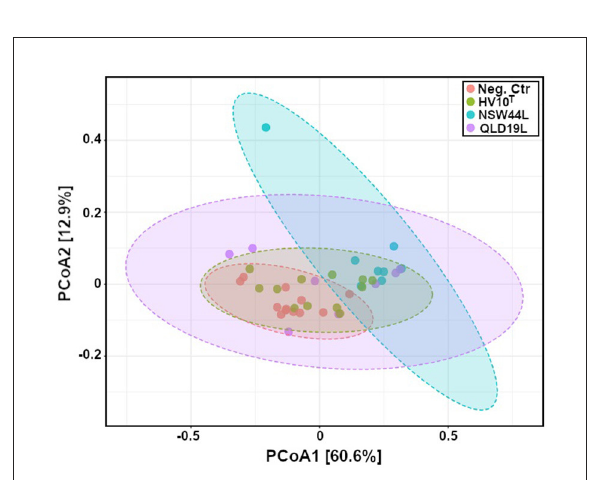
FIGURE5 Principal coordinates analysis (PCoA) of gut microbiota composition of C. hepaticus challenged groups compared with non-challenged birds (p < 0.001). The group challenged with the NSW44L strain was clustered away from the control group, but the separation was not obvious for the other two challenged